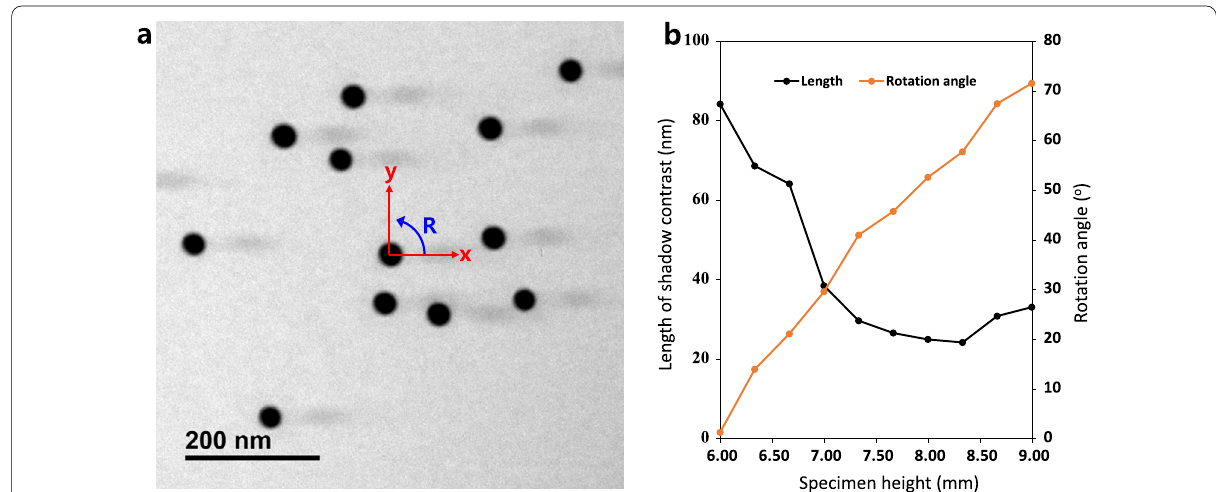
Fig. 3 Analysis of the shadow contrast images. a Specimen image obtained at an SH of 6 mm from the top of the lower P/P. The x‑axis direction represents the rotation origin of shadow contrast, and R represents the rotation direction. b Measurement results of the shadow contrast for each TEM